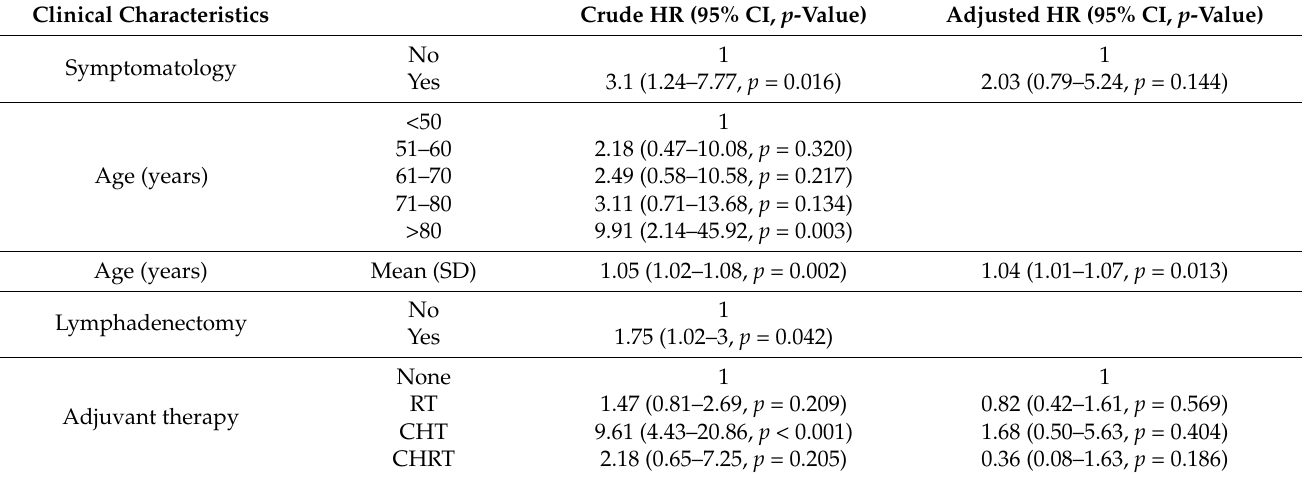
Table 2. Disease-free survival—univariable and multivariable Cox proportional hazards